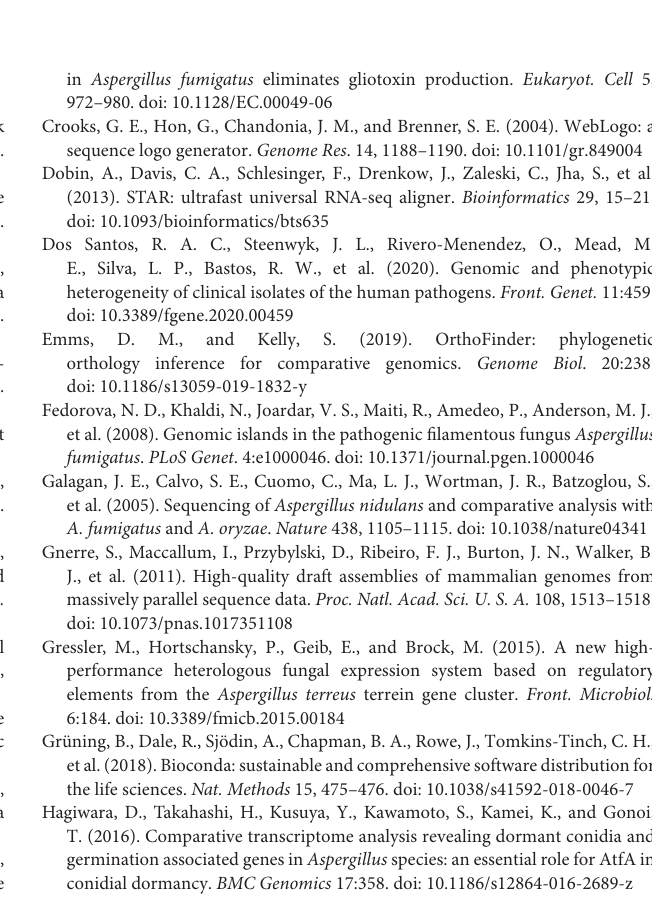
Supplementary Table 8 | Coordinately expressed gene clusters identified by MIDDAS-M analysis. Supplementary Table 9 | Comparison of t e r cluster between A. lentulus and A. terreus